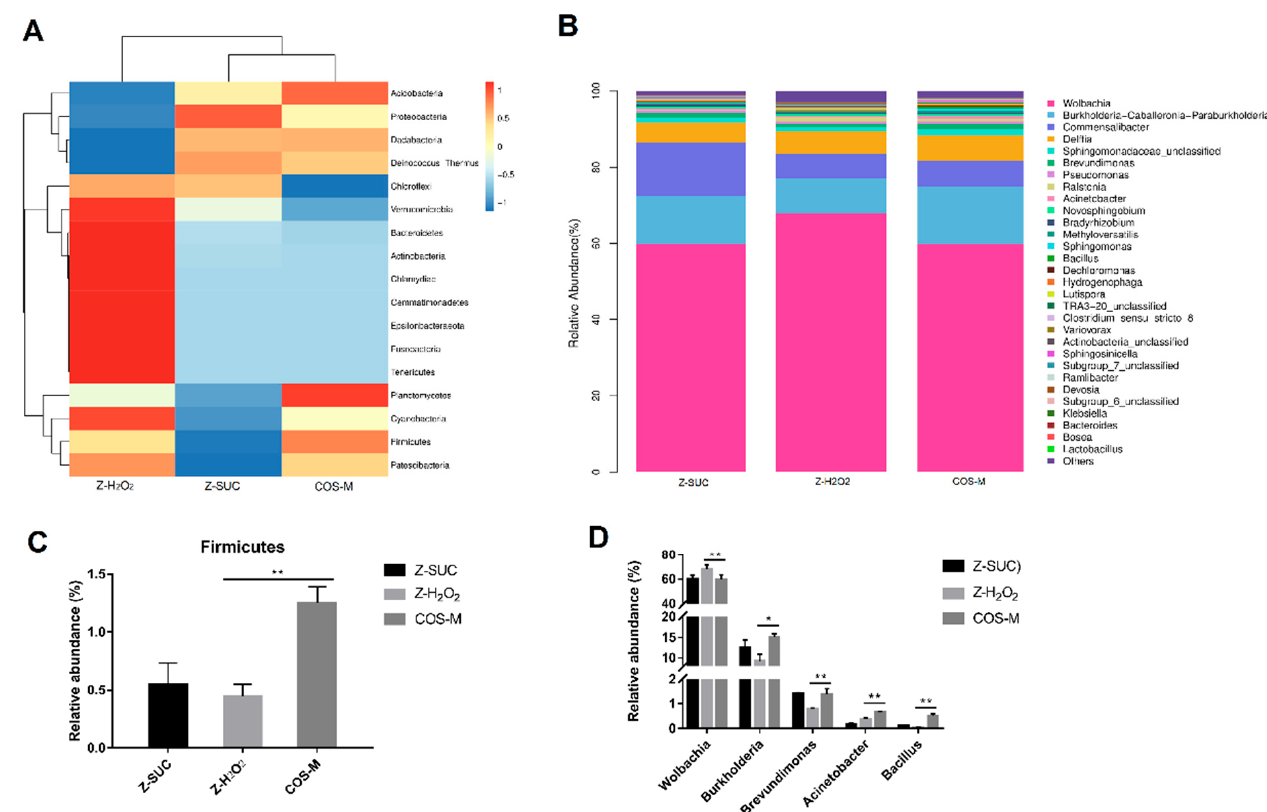
Figure 8. The relative abundance of the gut flora of Z-H 2 O 2 , Z-SUC, and COS-M groups at the phylum level ( A ), and genus level ( B ). The relative abundance of the gut flora of Z-H 2 O 2 , Z-SUC, and COS-M groups with significant differences at the phylum level ( C ), and genus level ( D ). Differences among treatments were obtained with one-way analysis of variance followed by Tukey’s multiple comparisons test, * and ** represent p < 0.05 and p < 0.01 respectively.